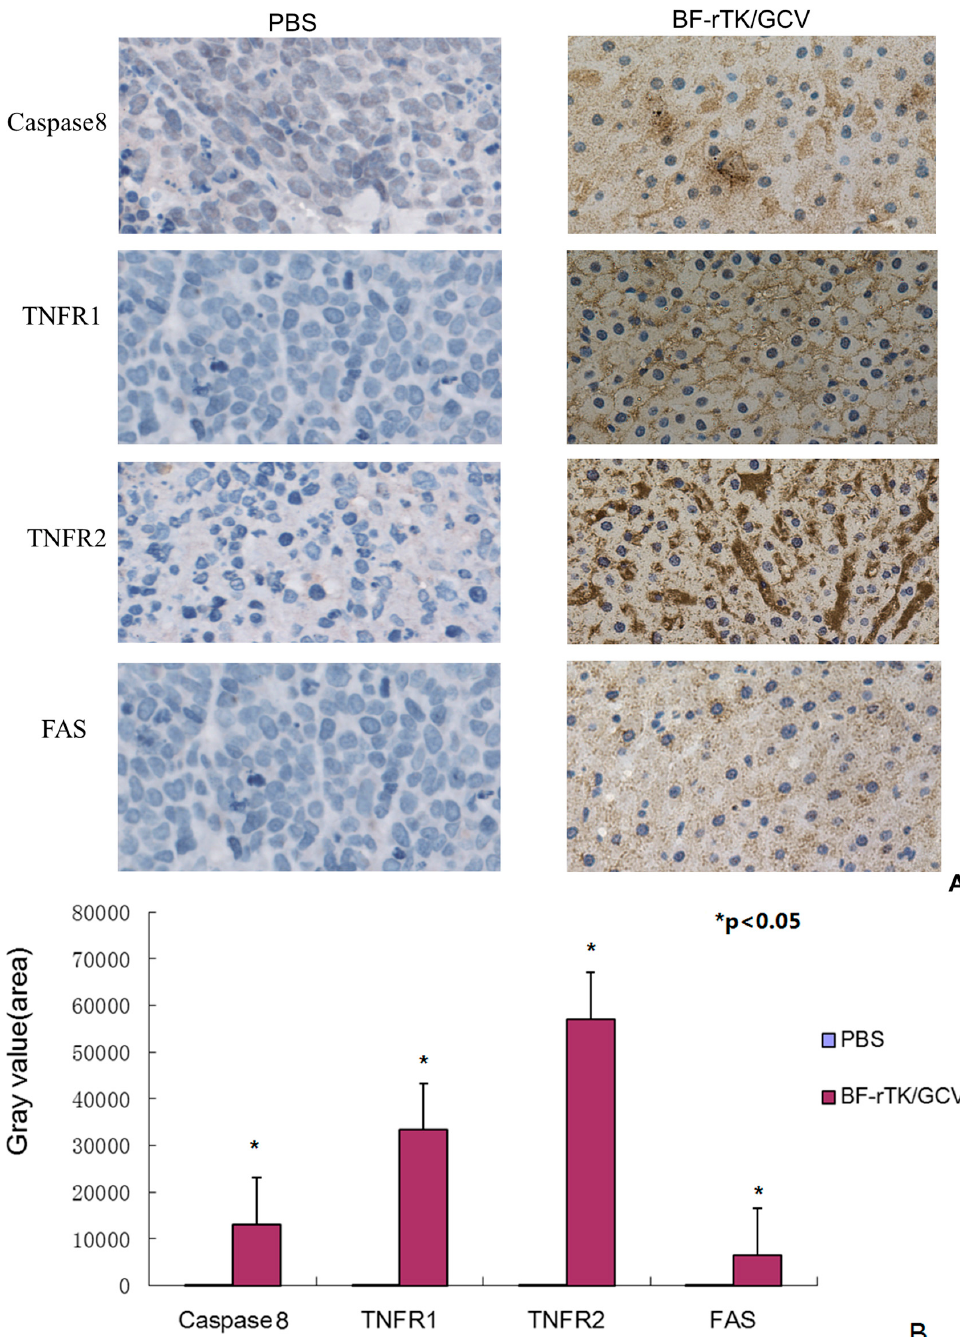
Figure 6. IHC assay of the tumor sample from nude mice treated by BF-rTK/GCV via IV ( n = 6). ( A ) The tumor tissue samples were from MKN-45 gastric cancer cells treated by PBS/GCV, and BF-rTK/GCV, respectively. The FAS, TNFR1, TNFR2, and caspase 8 levels were analyzed with IHC; ( B ) Quantitative analysis of FAS, TNFR1, TNFR2, and caspase 8 (* p < 0.05). 2.6. BF-rTK Regulates Caspase 8 Signaling Apoptosis-Associated Downstream Molecules in Intestinal